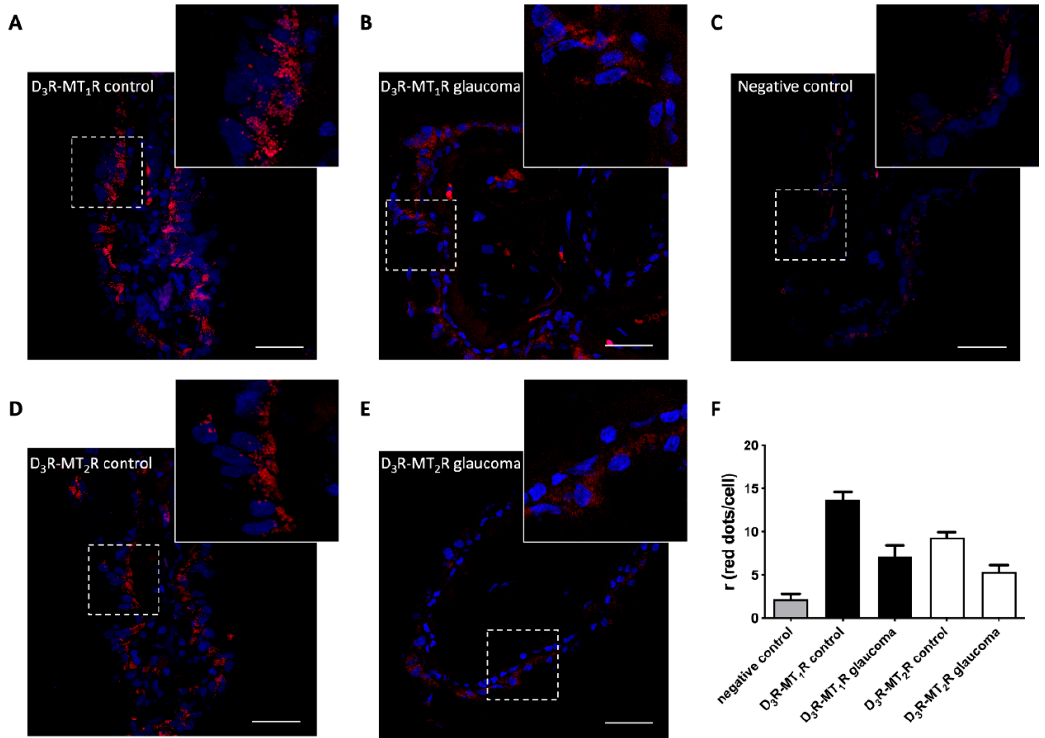
Figure 5. D 3 -MT 1 and D 3 -MT 2 receptor heteromer expression in the human ciliary body. In situ proximity ligation assays were performed as described in Materials and Methods using human ciliary body sections from age-matched intraocular pressure (IOP) normotensive individuals (control) ( A , C , D ) and glaucoma patients ( B , E ). Confocal microscopy images (superimposed sections) are shown. D 3 -MT 1 ( A , B ) and D 3 -MT 2 ( D , E ) receptor heteromers appear as red clusters and Hoechst-stained nuclei appear in blue. ( C ) A negative control obtained by omitting one of the